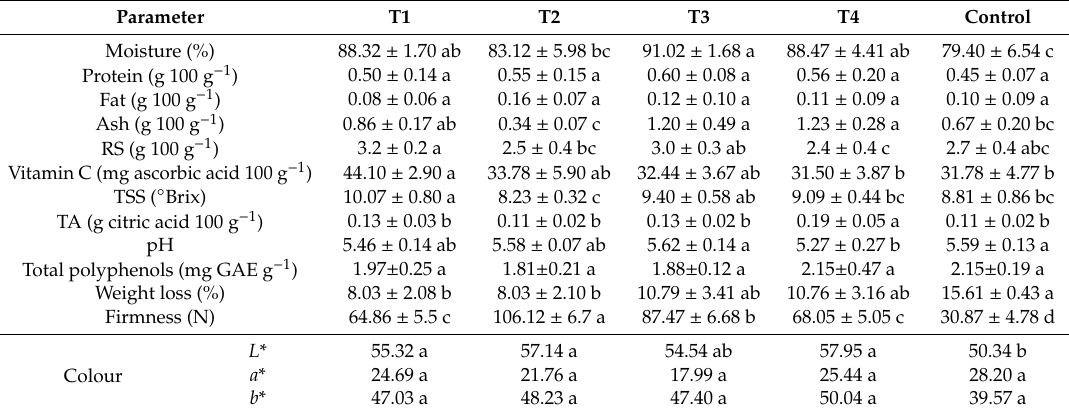
Table 3. Physical characteristics and chemical composition of Maradol papaya fruits grown using di ff erent agronomic strategies and stored for 8 days at 30 ± 2 ◦ C, with the subsequent 7 days at 15 ◦ C. Parameter